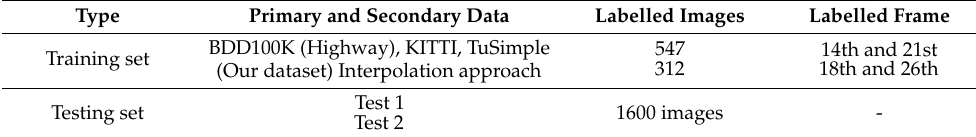
Table 2. Training and testing